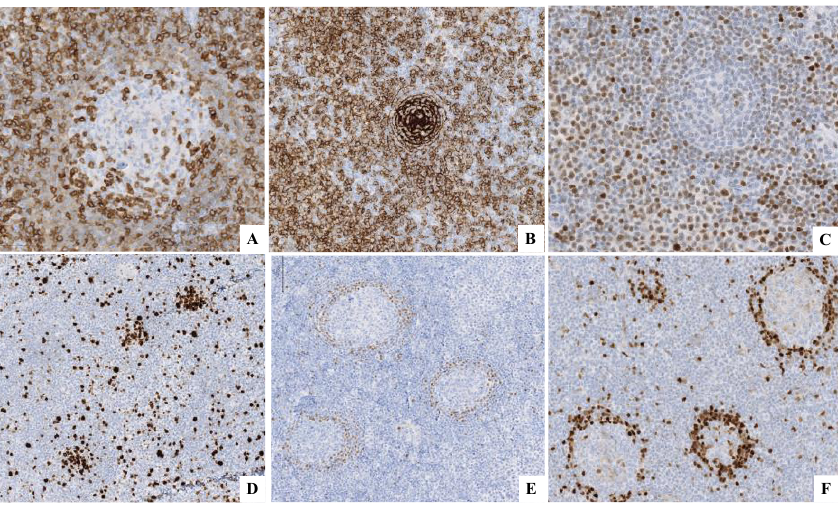
Figure 2. ( A ) CD5+ in both components. ( B ) CD23+ in the SLL component. (C) LEF1+ in the SLL component. ( D ) Ki-67 highlights the proliferation centers. ( E ) Cyclin D1+ in the ISMCN. ( F ) SOX11+ in the ISMCN.